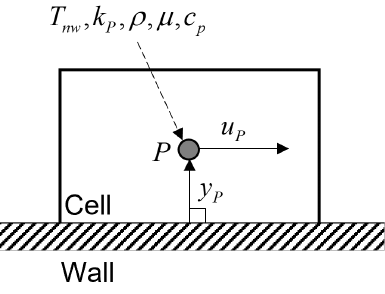
Figure 3. Variables stored in a cell centre P of a wall adjacent